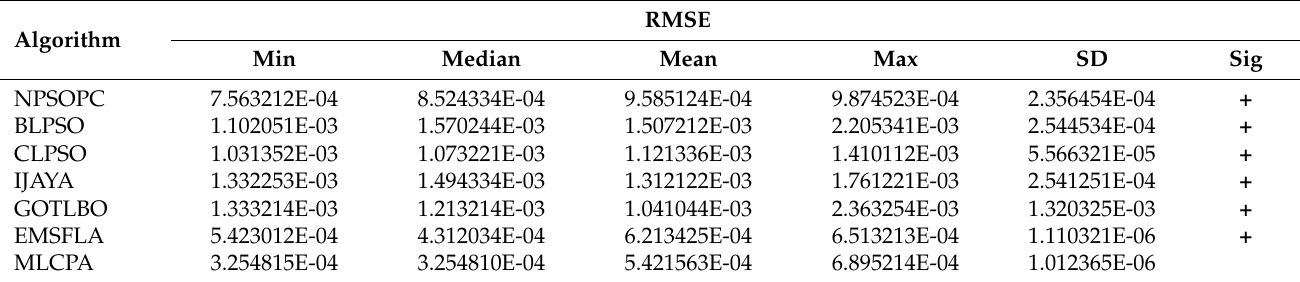
Table 6. RMSE of SDM.